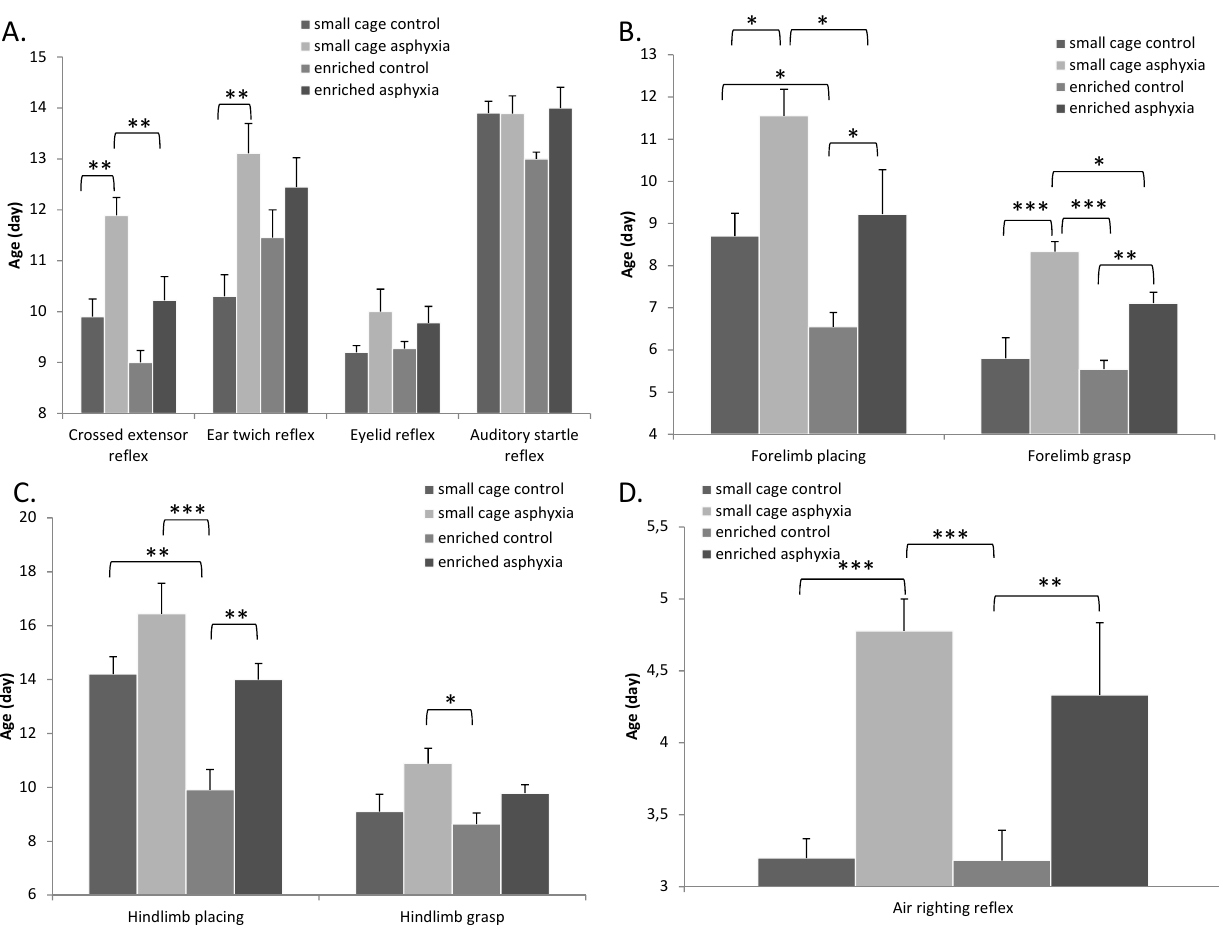
Figure 2. ( A ) Appearance of crossed extensor reflex, ear twitch-, eyelid reflex and auditory startle reflex; ( B ) Appearance of forelimb placing and grasp; ( C ) Appearance of hindlimb placing and grasp; and ( D ) Air righting reflex appearance (* p < 0.05, ** p < 0.01, *** p < 0.001).